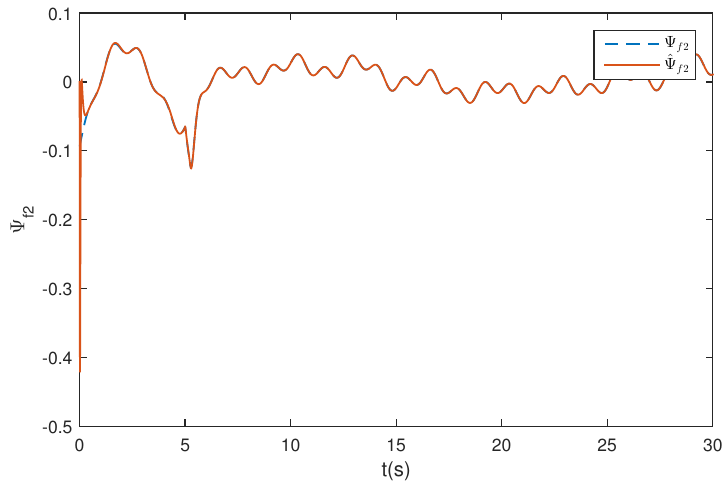
Figure 10. Estimation of Ψ f 2 in attitude tracking.